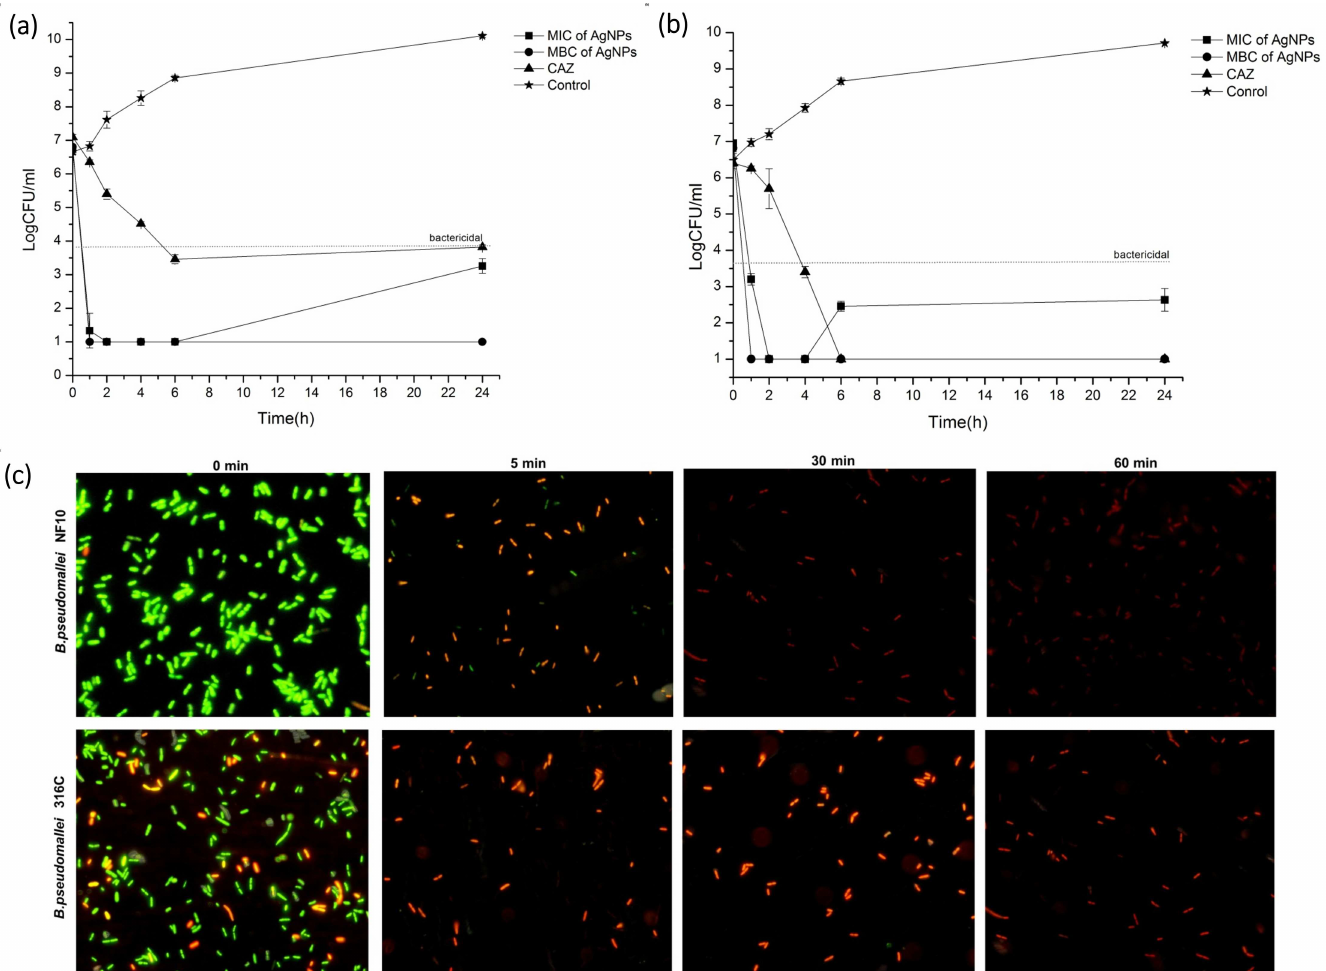
Fig 2. Killing kinetics of AgNPs against B . pseudomallei . Bacterial suspensionstrains NF10 (a) or 316a (b) were incubatedwith various concentrations of AgNPs and CAZ for 1, 2, 4, 6 and 24 h. Colonieswere counted, and the bactericidal effects were definedas a (cid:21) 3-log reduction in colony-forming units (CFU)/mL comparedto the initial inoculum.Short-term effects of AgNPs against B . pseudomallei NF10 and 316c were determined0, 5, 30 and 60 min after exposure to AgNPs using a LIVE/DEAD ® BacLightTM bacteria viabilitykit by fluorescence microscopy (c). Data represent the means ± standard errors of the means for triplicate samples.Results shown are representative of two